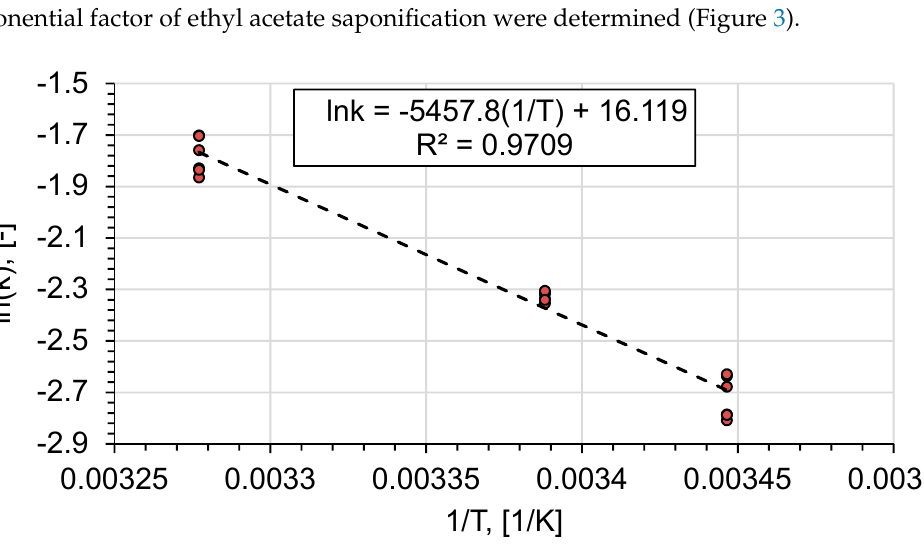
Figure 3. Arrhenius plot for saponification of ethyl acetate.